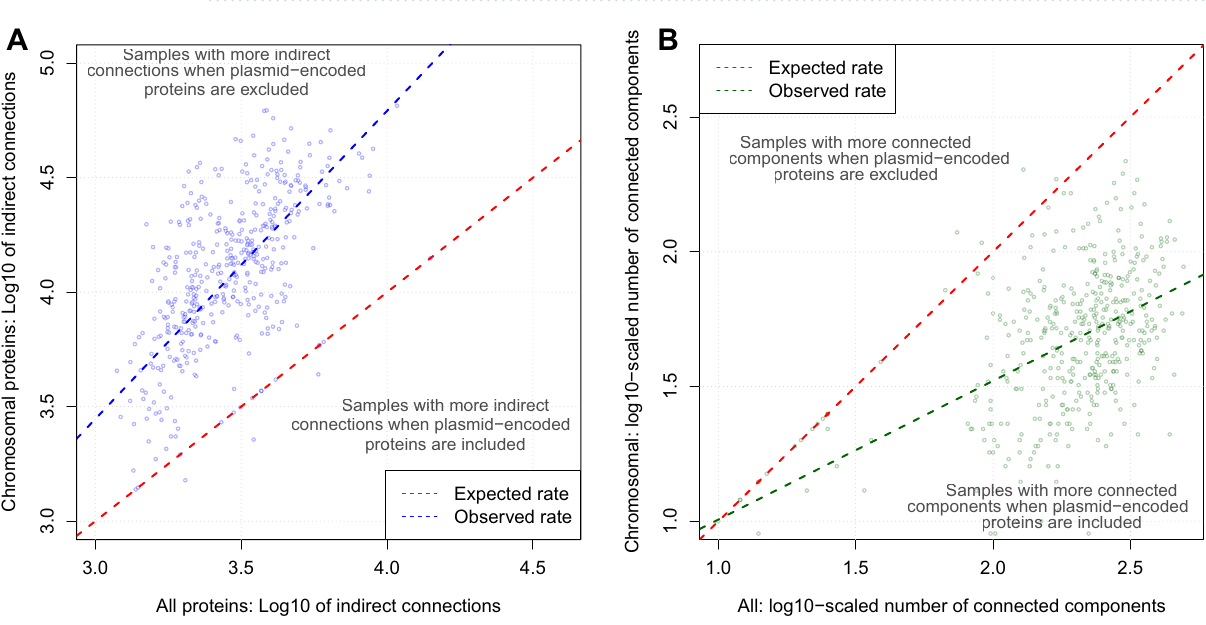
Figure 7. The log10-scaled numbers of ( A ) indirect connections (blue) and ( B ) connected components (green) for all (chromosomal and plasmid) proteins (x-axis) related to chromosomal proteins only (y-axis) for the 489 samples with plasmid-related PPIs. The red lines show the expected rate if ( A ) the numbers of indirect connections for all proteins and chromosomal proteins were identical and ( B ) the numbers of connected components for all proteins and chromosomal proteins were identical. ( A ) The blue line shows the correlation between the numbers of indirect connections for all proteins and chromosomal proteins (> 98% of samples had more indirect connections when plasmid-related proteins were omitted). ( B ) The green line shows the correlation between the numbers of connected components for all proteins and chromosomal proteins (> 97% of samples had more connected components when plasmid-related proteins were